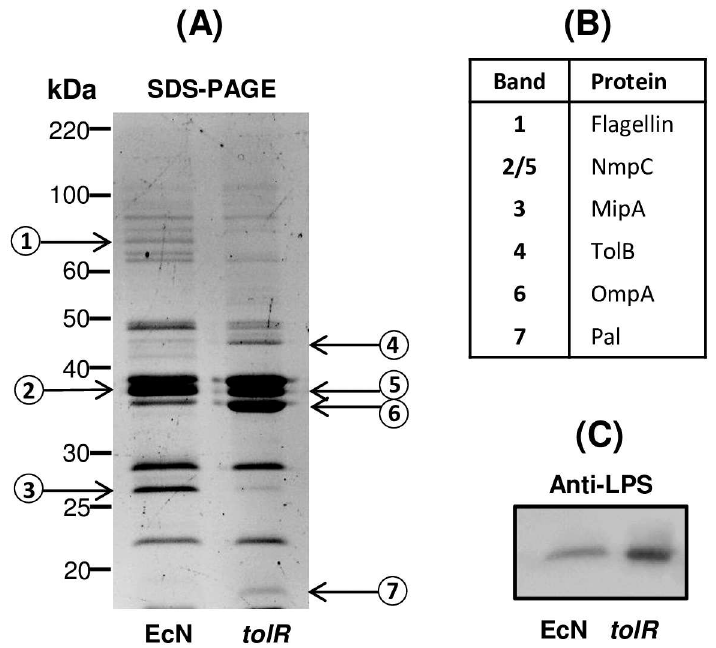
Fig 2. Protein profile and immunoblotting of LPS of MVs isolated from EcN and EcN tolR strains. (A) Comparison of the protein profile of MVs from EcN and EcN tolR . Isolated vesicles (10 μ g protein) were separated in a 10%-SDS-PAGE gel and stained with Sypro ® Ruby Protein Gel Stain. Molecularsize markers are indicated. Seven protein bands(labelledby numbers)were excised from the gel and analyzedby LC-MS/ MS (data from these analysesare providedin S1 Table). (B) The name of the protein with the highest score is indicatedfor each band. (C) Western blot analysisof LPS in MVs isolatedfrom EcN and EcN tolR strains. MV samples (0.1 μ gprotein) were separated in a 15%-SDS-PAGE gel and analysedwith specific anti- E . coli LPS antibodies. Representative SDS-PAGE and blots from three independentexperiments are shown.